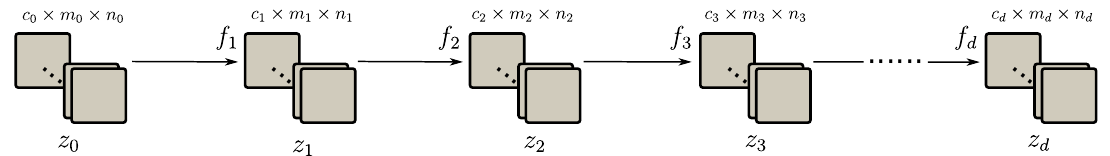
Figure 1. Schematic architecture of a neural network for image processing. Squares denote feature map channels and arrows denote function inputs. The depth of the network is given by d .